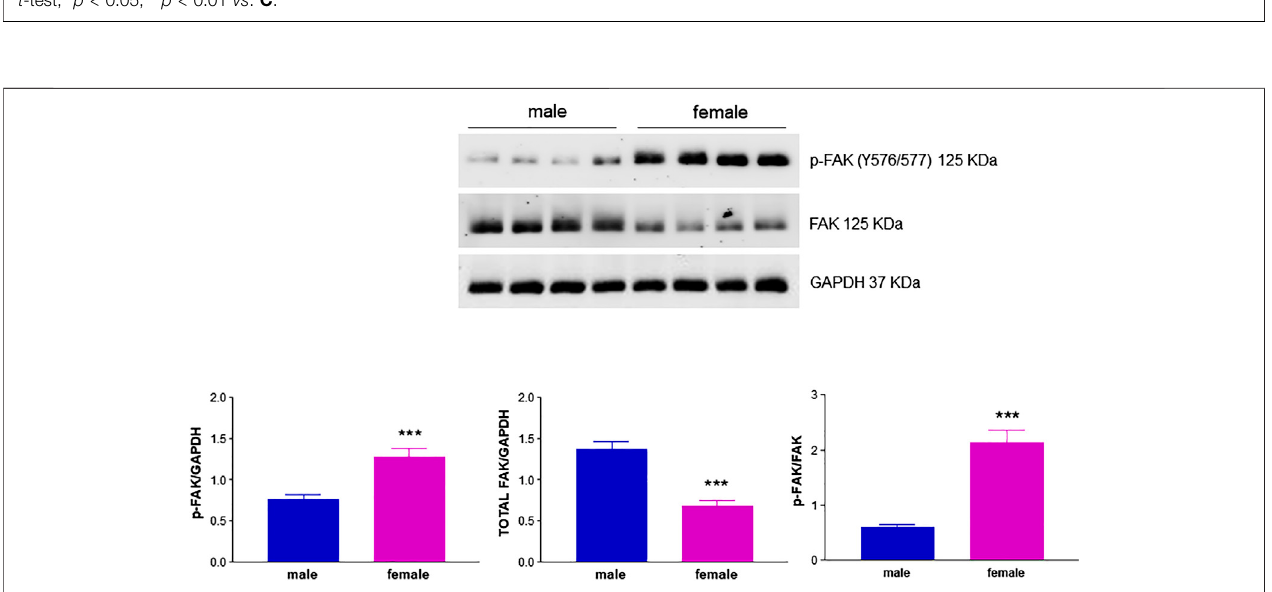
FIGURE 7 | Effect of HUVEC donor ’ s sex on FAK activation. HUVECs were seeded in 35-mm dishes in M199 complete medium. Upper panel : Representative Western blots showing the expression of p-FAK (Y576/577) and total FAK; GAPDH was used as loading control. Lower panel : Densitometric analysis of bands normalized to GAPDH levels and p-FAK/FAK ratio. Each independent experiment ( n (cid:1) 4) was performed using cells from four male and four female donors. Data are shown as the mean ± SEM of 16 male and 16 female donors. t -test, *** p < 0.001.